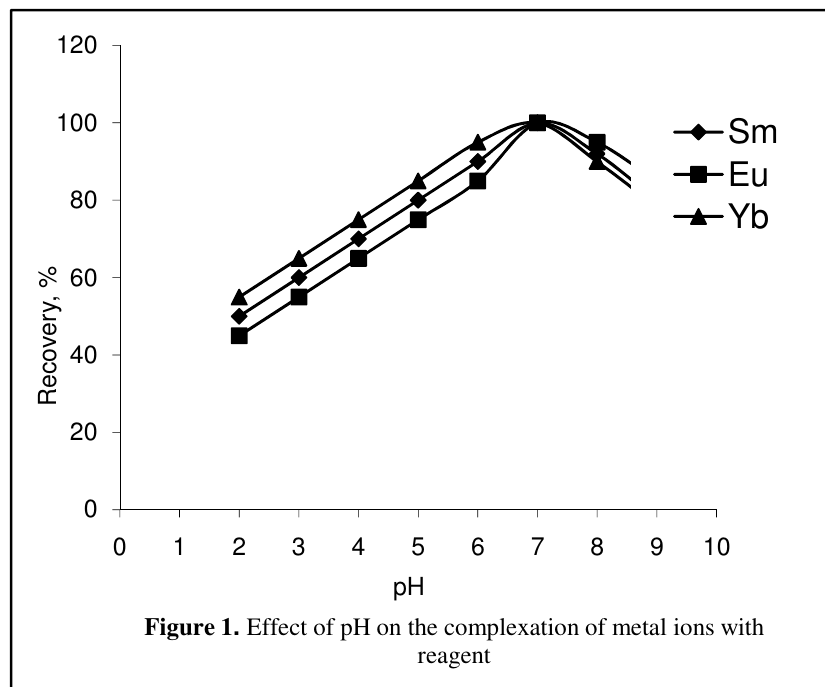
Figure 1 . Effect of pH on the complexation of metal ions with